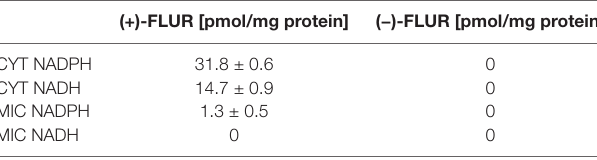
(+)-FLUR [pmol/mg protein] (−)-FLUR [pmol/mg protein]